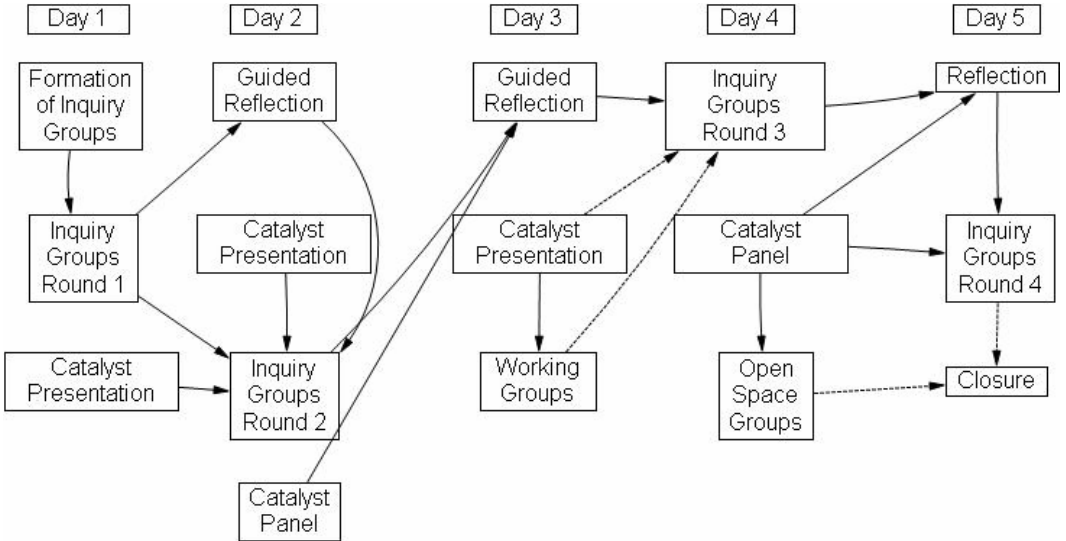
F IGURE 1: O UTLINE OF THE FIVE - DAY C LIMATE C HANGE AND T RANSFORMING ENERGY C OURAGEOUS C